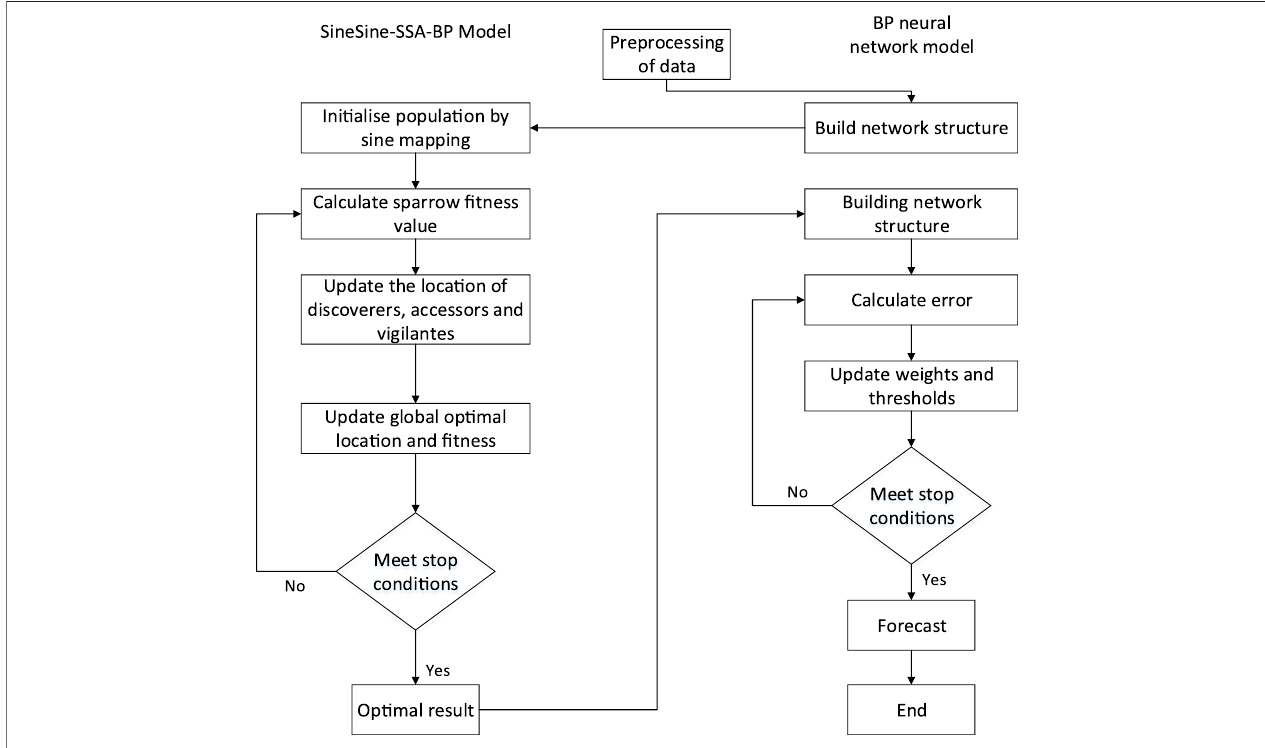
FIGURE 8 | Flow chart depicting the process of the Sine-SSA-BP algorithm. Field application of the Sine-SSA-BP algorithm.